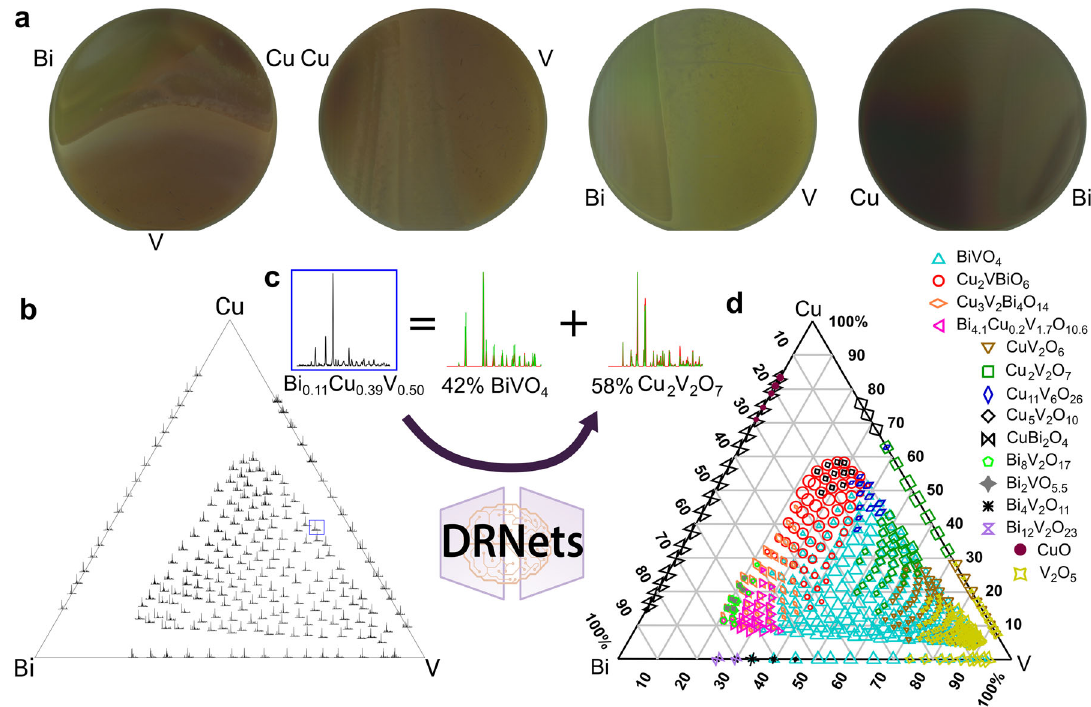
Fig. 1 Phase mapping in the Bi-Cu-V oxide system. a Photographs of 4 sputter-deposited composition libraries in Bi – Cu – V oxide system. b Representative x-ray diffraction patterns collected on the composition libraries, where each XRD pattern is plotted at the location of the composition in the Bi – Cu – V composition graph. c The DRNets solution for one composition, showing that the XRD pattern of the Bi 0.11 Cu 0.39 V 0.50 oxide sample is composed of 42% BiVO 4 and 58% Cu 2 V 2 O 7 . d The resulting phase map of the primary 14 of the 21 phases identi fi ed by DRNets, where each phase has a unique symbol whose point size indicates phase concentration in the composition graph. Multi- phase samples have multiple overlapping